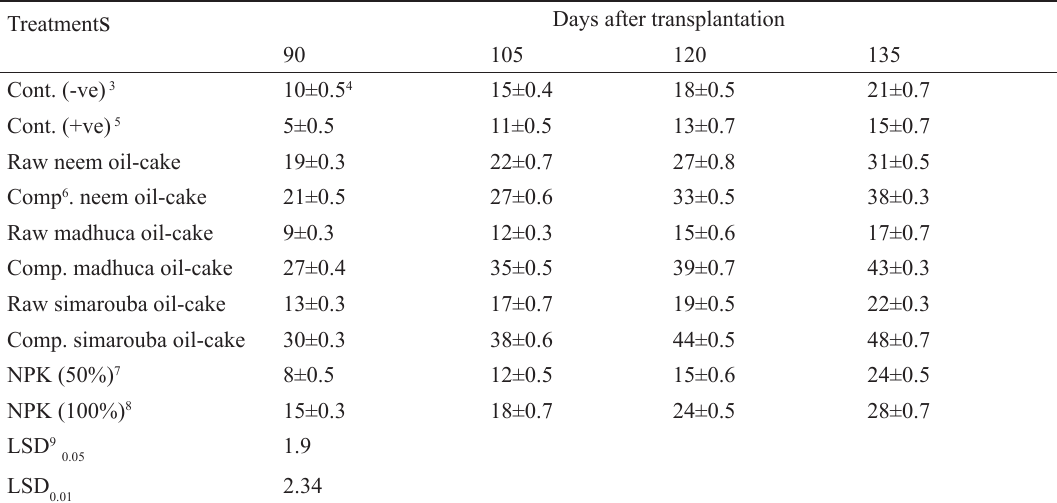
Table 3 Effect of soil amendment with raw and composted oil-cakes of neem, madhuca and simarouba on the num- ber of chilli fruits 1 harvested at different intervals in the field 2 Treatment s Days after